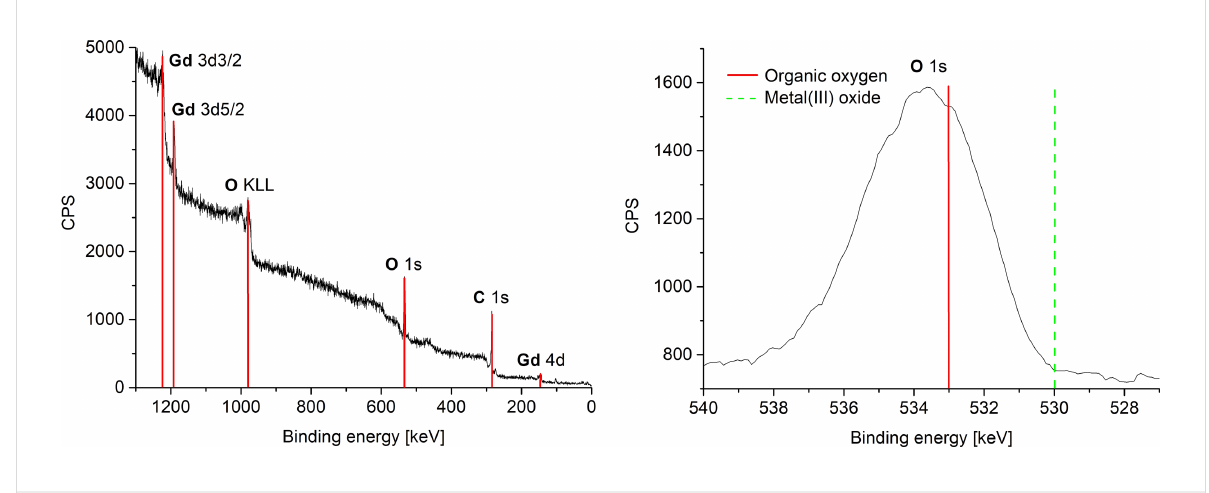
Figure 10: HR-XPS of 1.0 wt % Gd-NPs in PC from Gd(amd) 3 . The red and green bars are a guide to the eye on the binding-energy axis.